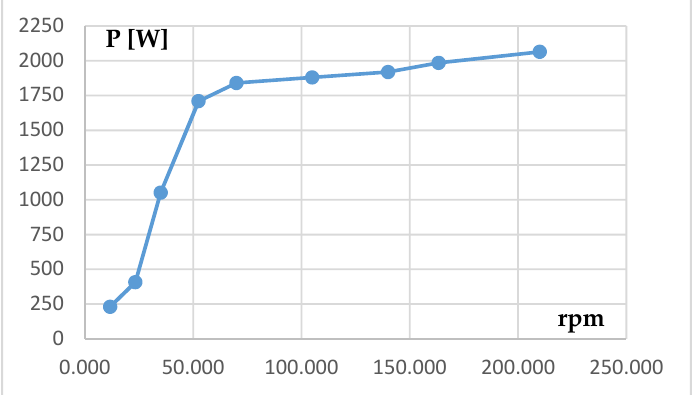
Figure 22. Delivered power in function of the EM rpm.